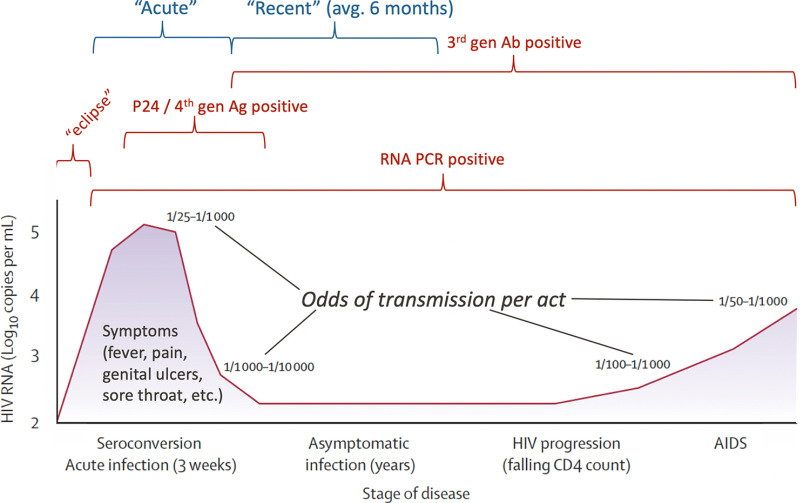
The Natural History of HIV Disease Progression in the Absence of Antiretroviral Therapy, Variable Transmission Probabilities Associated With Viral Burden, and Capacities for Detection of HIV Infection Through Different DiagnosticsAbbreviations: Ag, antigen; Ab, antibody; PCR, polymerase chain reaction.